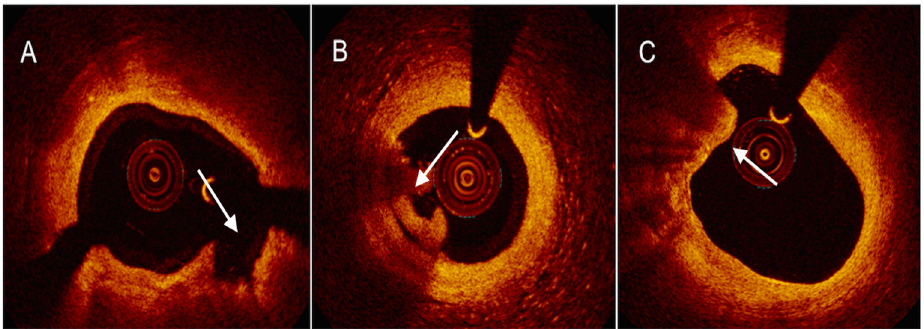
Figure 4. Examples of OCT-derived mechanisms of plaque destabilization. ( A ) Example of a ruptured plaque, characterized by the evidence of a cavity with a clear discontinuity of the fibrous cap (( A ), white arrow). ( B ) Example of a definite eroded plaque, characterized by a luminal thrombus (( B ), white arrow) overlying a plaque without evidence of fibrous cap disruption. ( C ) Example of a calcific nodule (( C ), white arrow), depicted as single of multiple regions of calcium that protrude into the lumen with fibrous cap disruption.